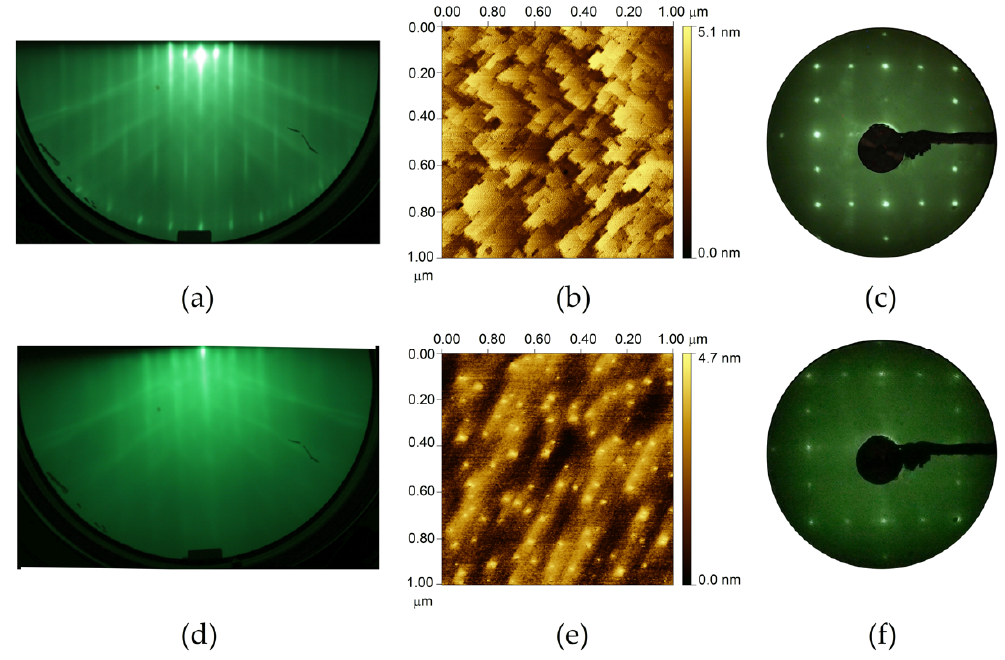
Figure 1. ( a ) RHEED pattern, ( b ) STM image, and ( c ) LEED pattern of MBE as-grown 4 nm–thick Si 0.5 Ge 0.5 on epi Ge(001)-2 × 1, and ( d ) RHEED pattern, ( e ) STM image, and ( f ) LEED pattern of MBE as-grown 1 nm–thick Si 0.1 Ge 0.9 on epi Si(001)-2–1. STM images are 1 µ m × 1 µ m in size. The electron beam energy of the LEED images was 40 eV.